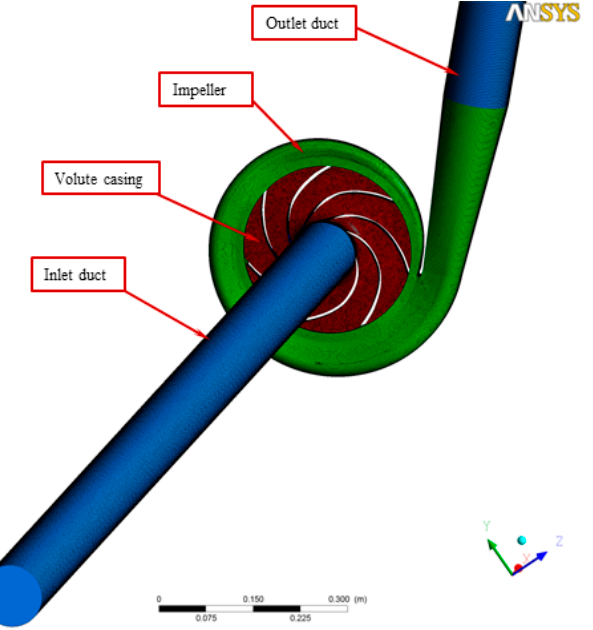
Figure 6. The unstructured meshes of the draft tubes (inlet and outlet pipes).